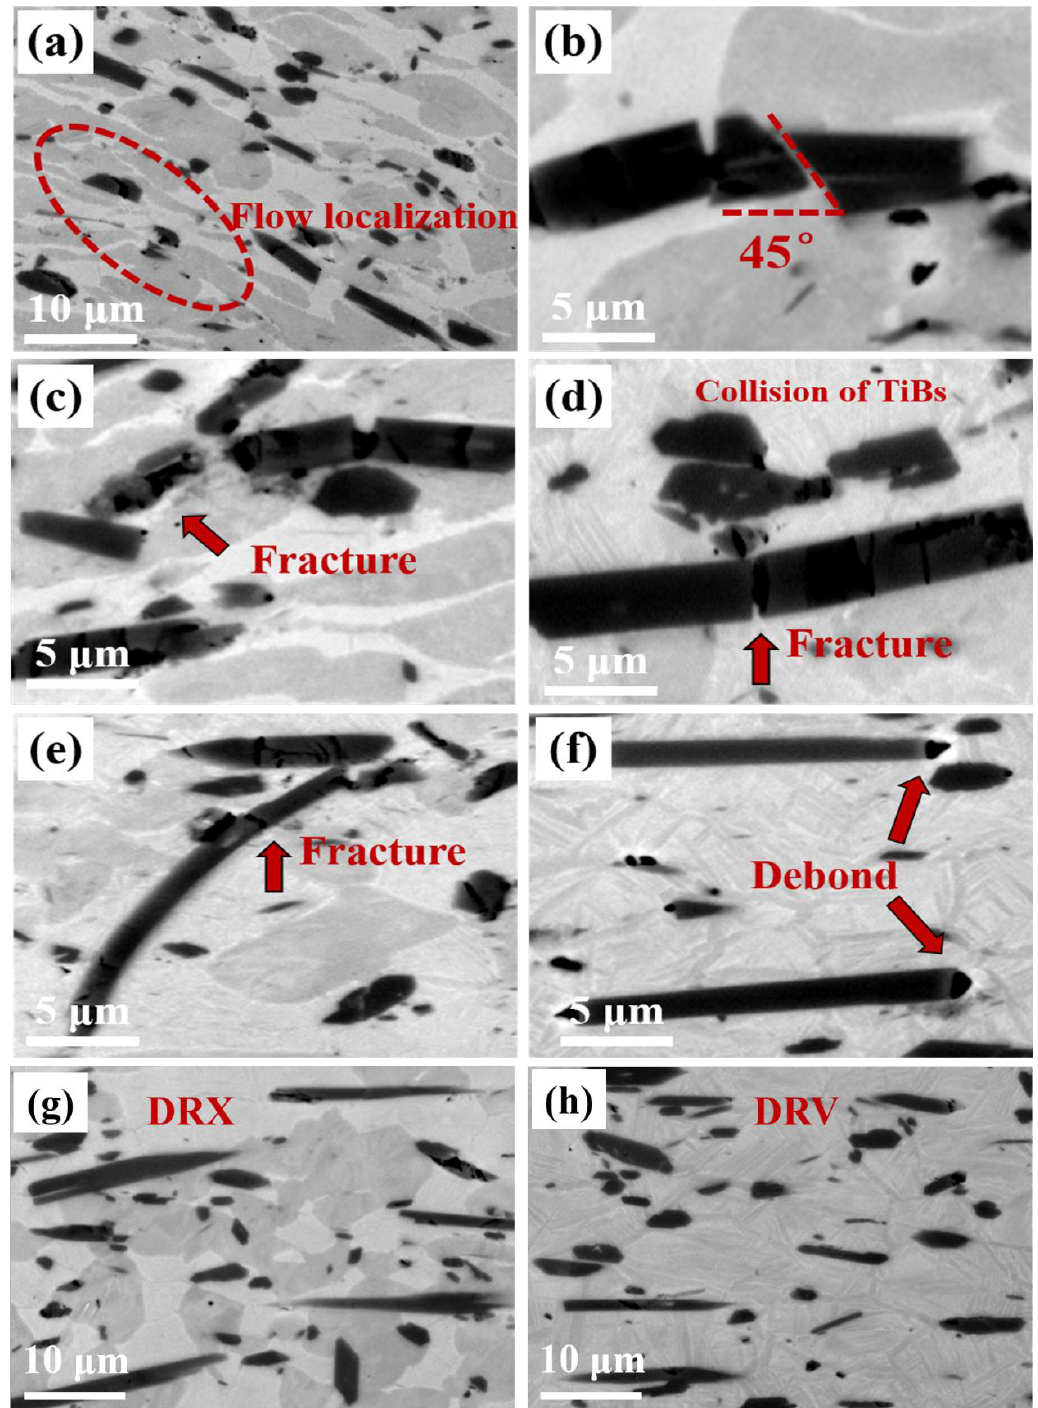
Figure 6. Microstructures of the UF-TiB/Ti-6Al-4V composite deformed at different conditions: ( a ) 900 ( h ) 1100 ◦ C/0.001 s − 1